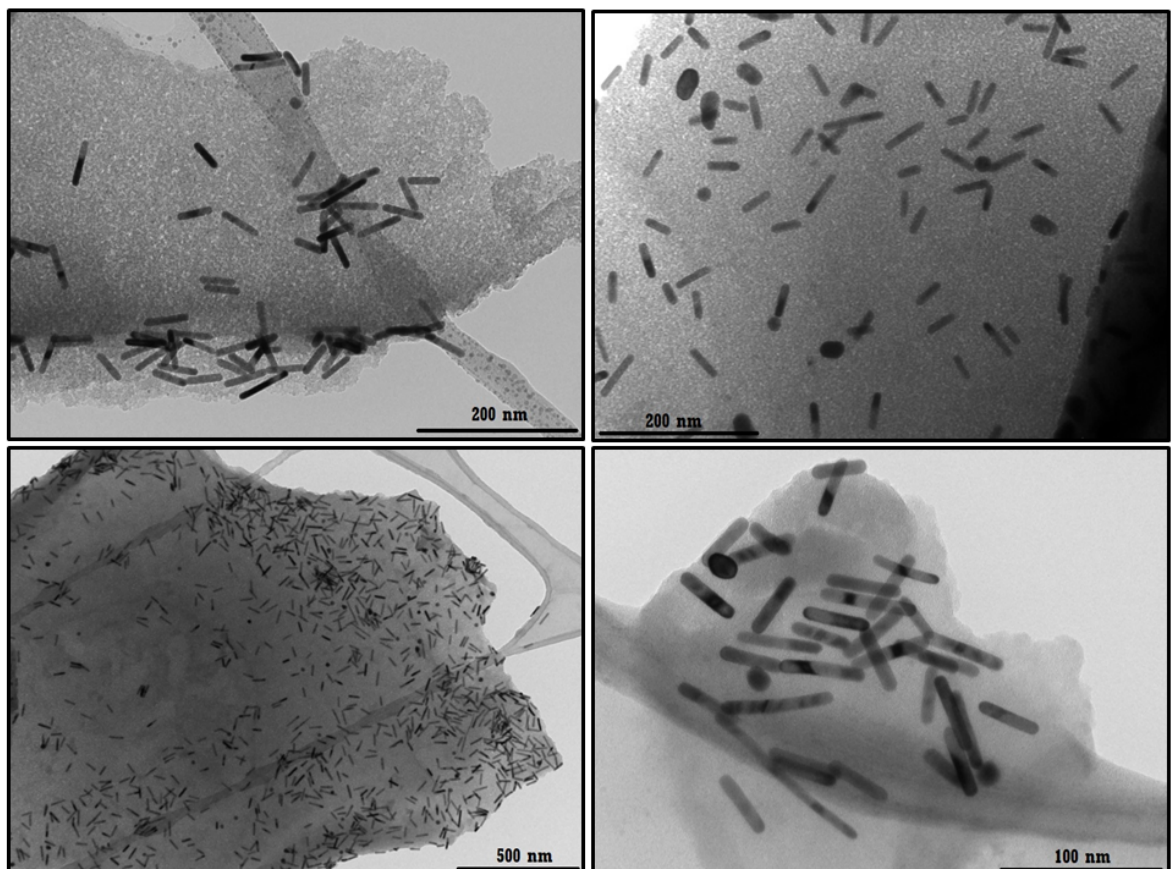
Figure 14. TEM images of the ICs associated with AuNRs.